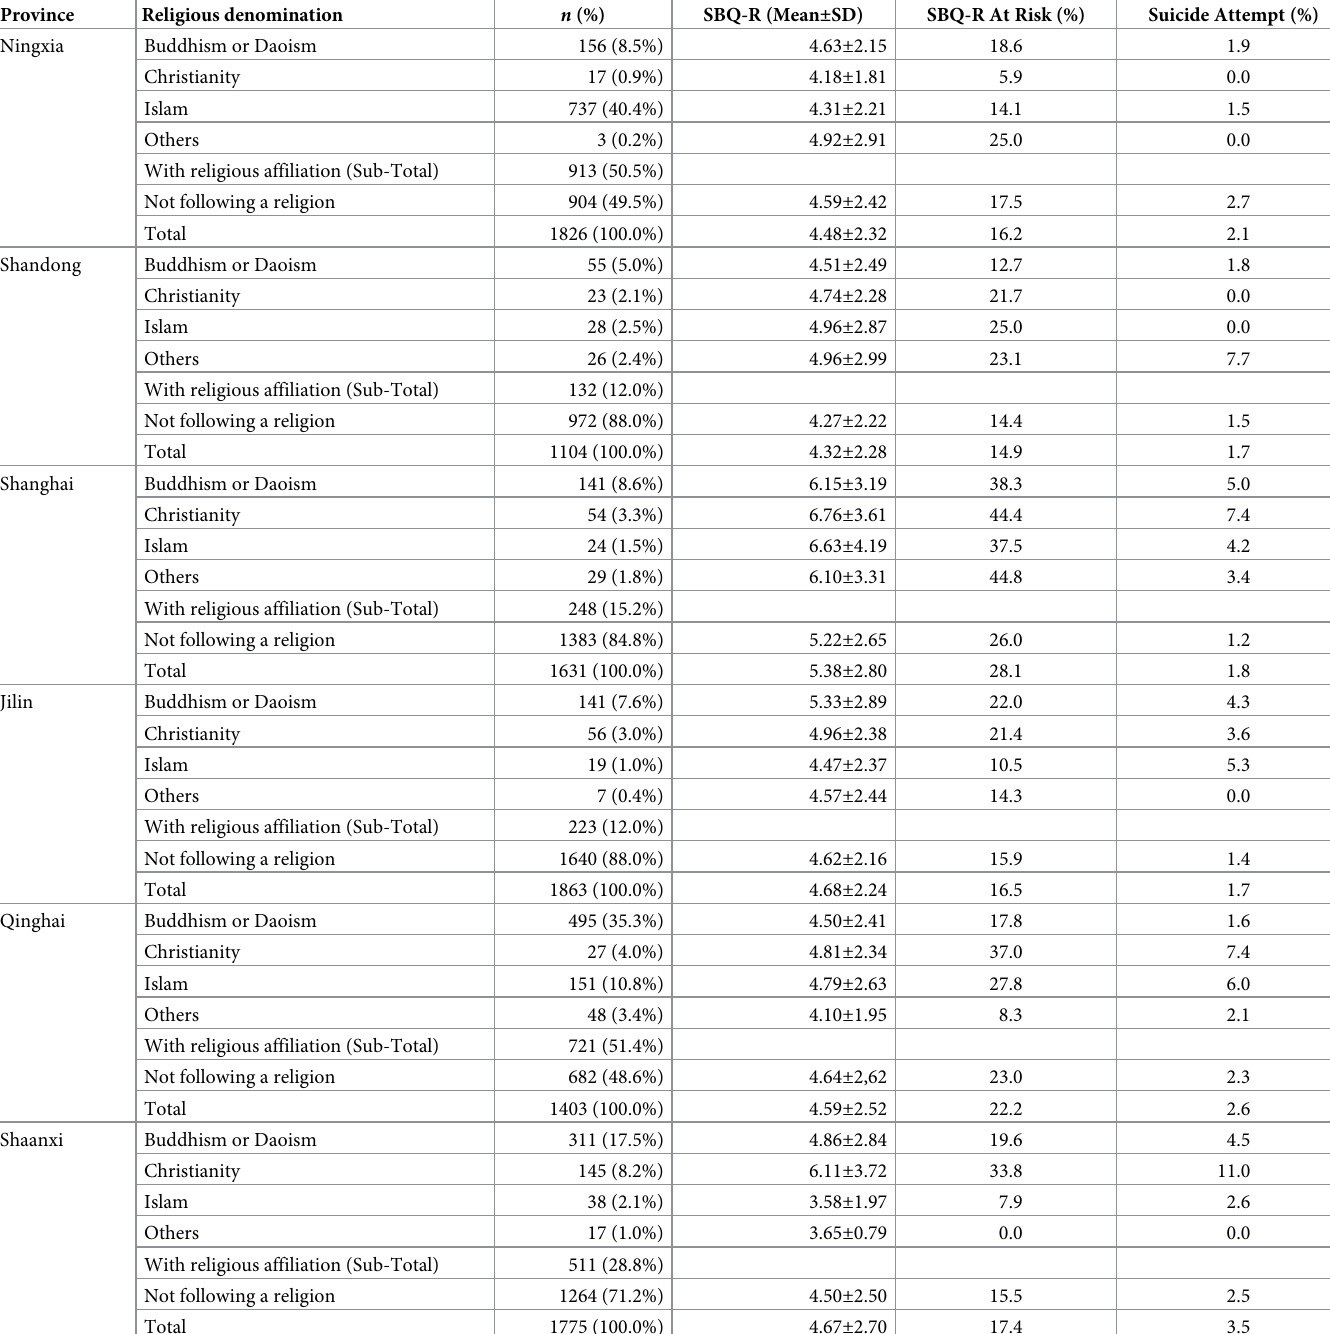
Table 1. Suicidality measures by province and religious